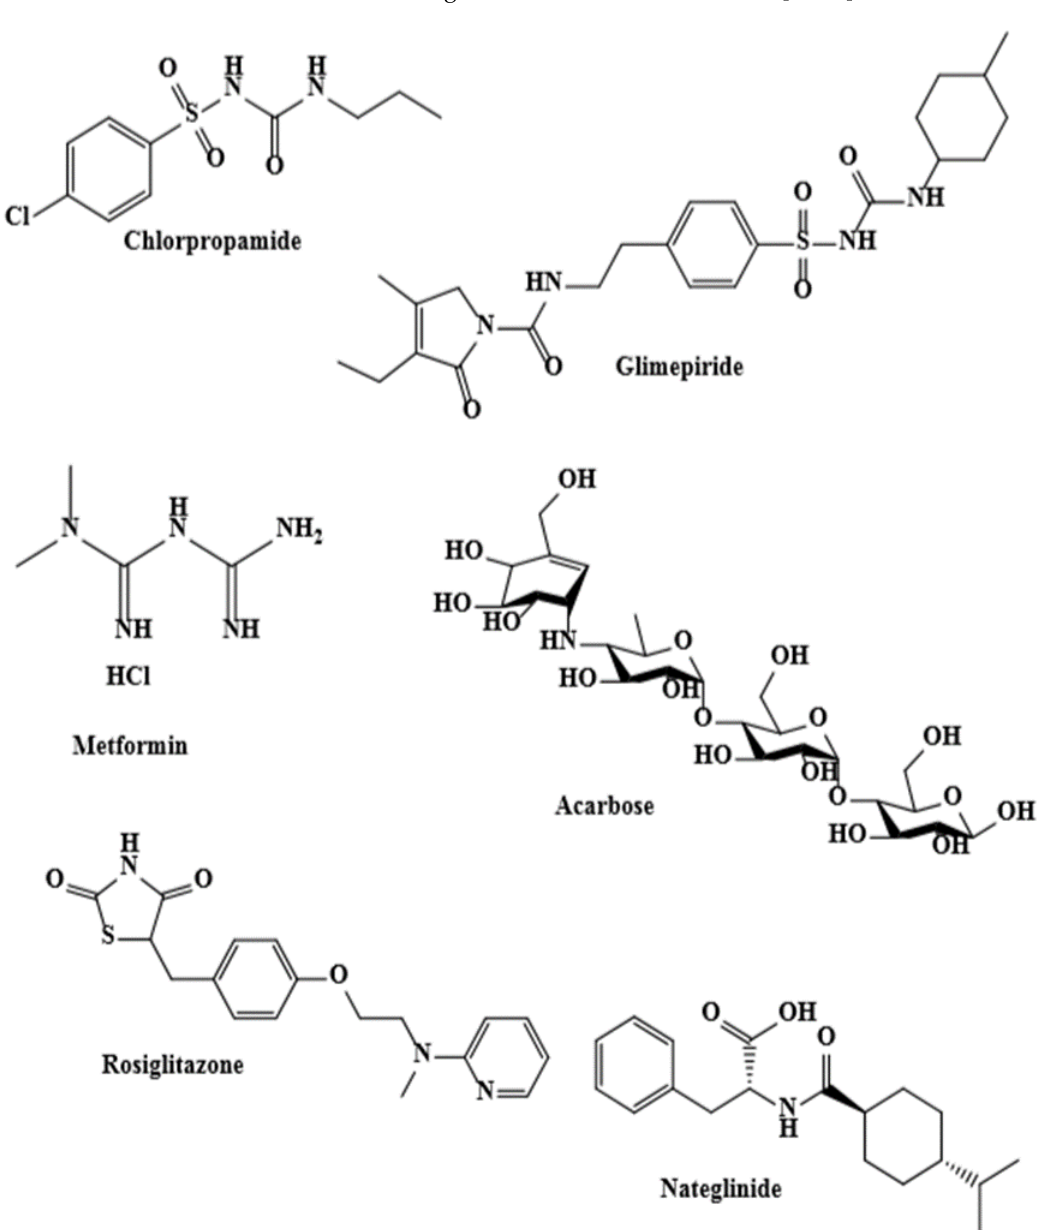
Figure 2. Representative oral synthetic antidiabetic agents [40]. Copyright: © 2014 Singab AN, et al.